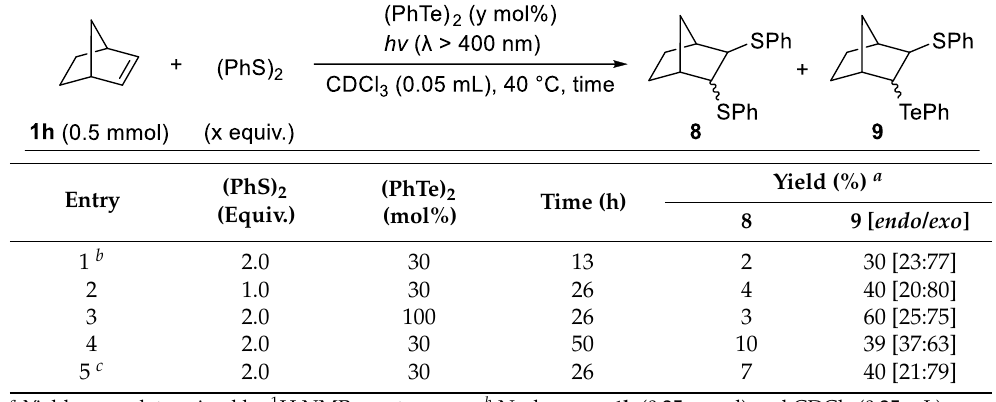
Table 3. Attempted dithiolation of norbornene 1h assisted by (PhTe) 2 under photoirradiation.